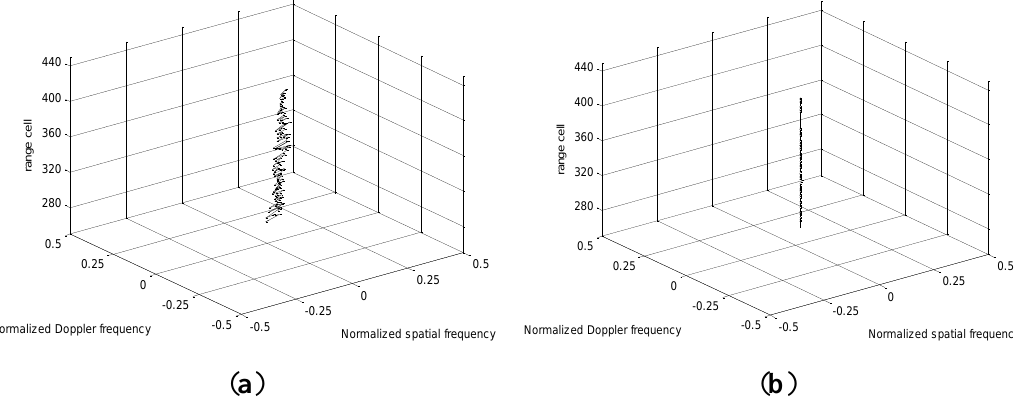
Figure 5. SCs migration over range. ( a ) Before compensation; ( b ) After Compensation.